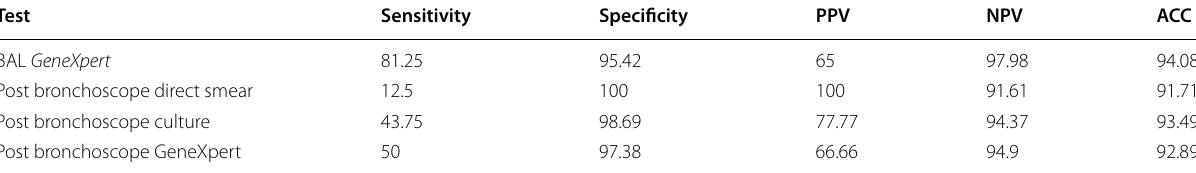
BAL bronchoalveolar lavage, N number, PPV positive predictive value, NPV negative predictive value, ACC